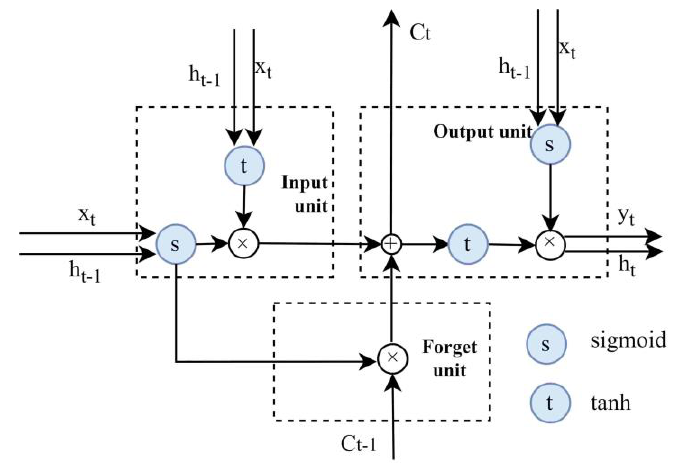
Figure 5. Architecture of the memory block at time step t.